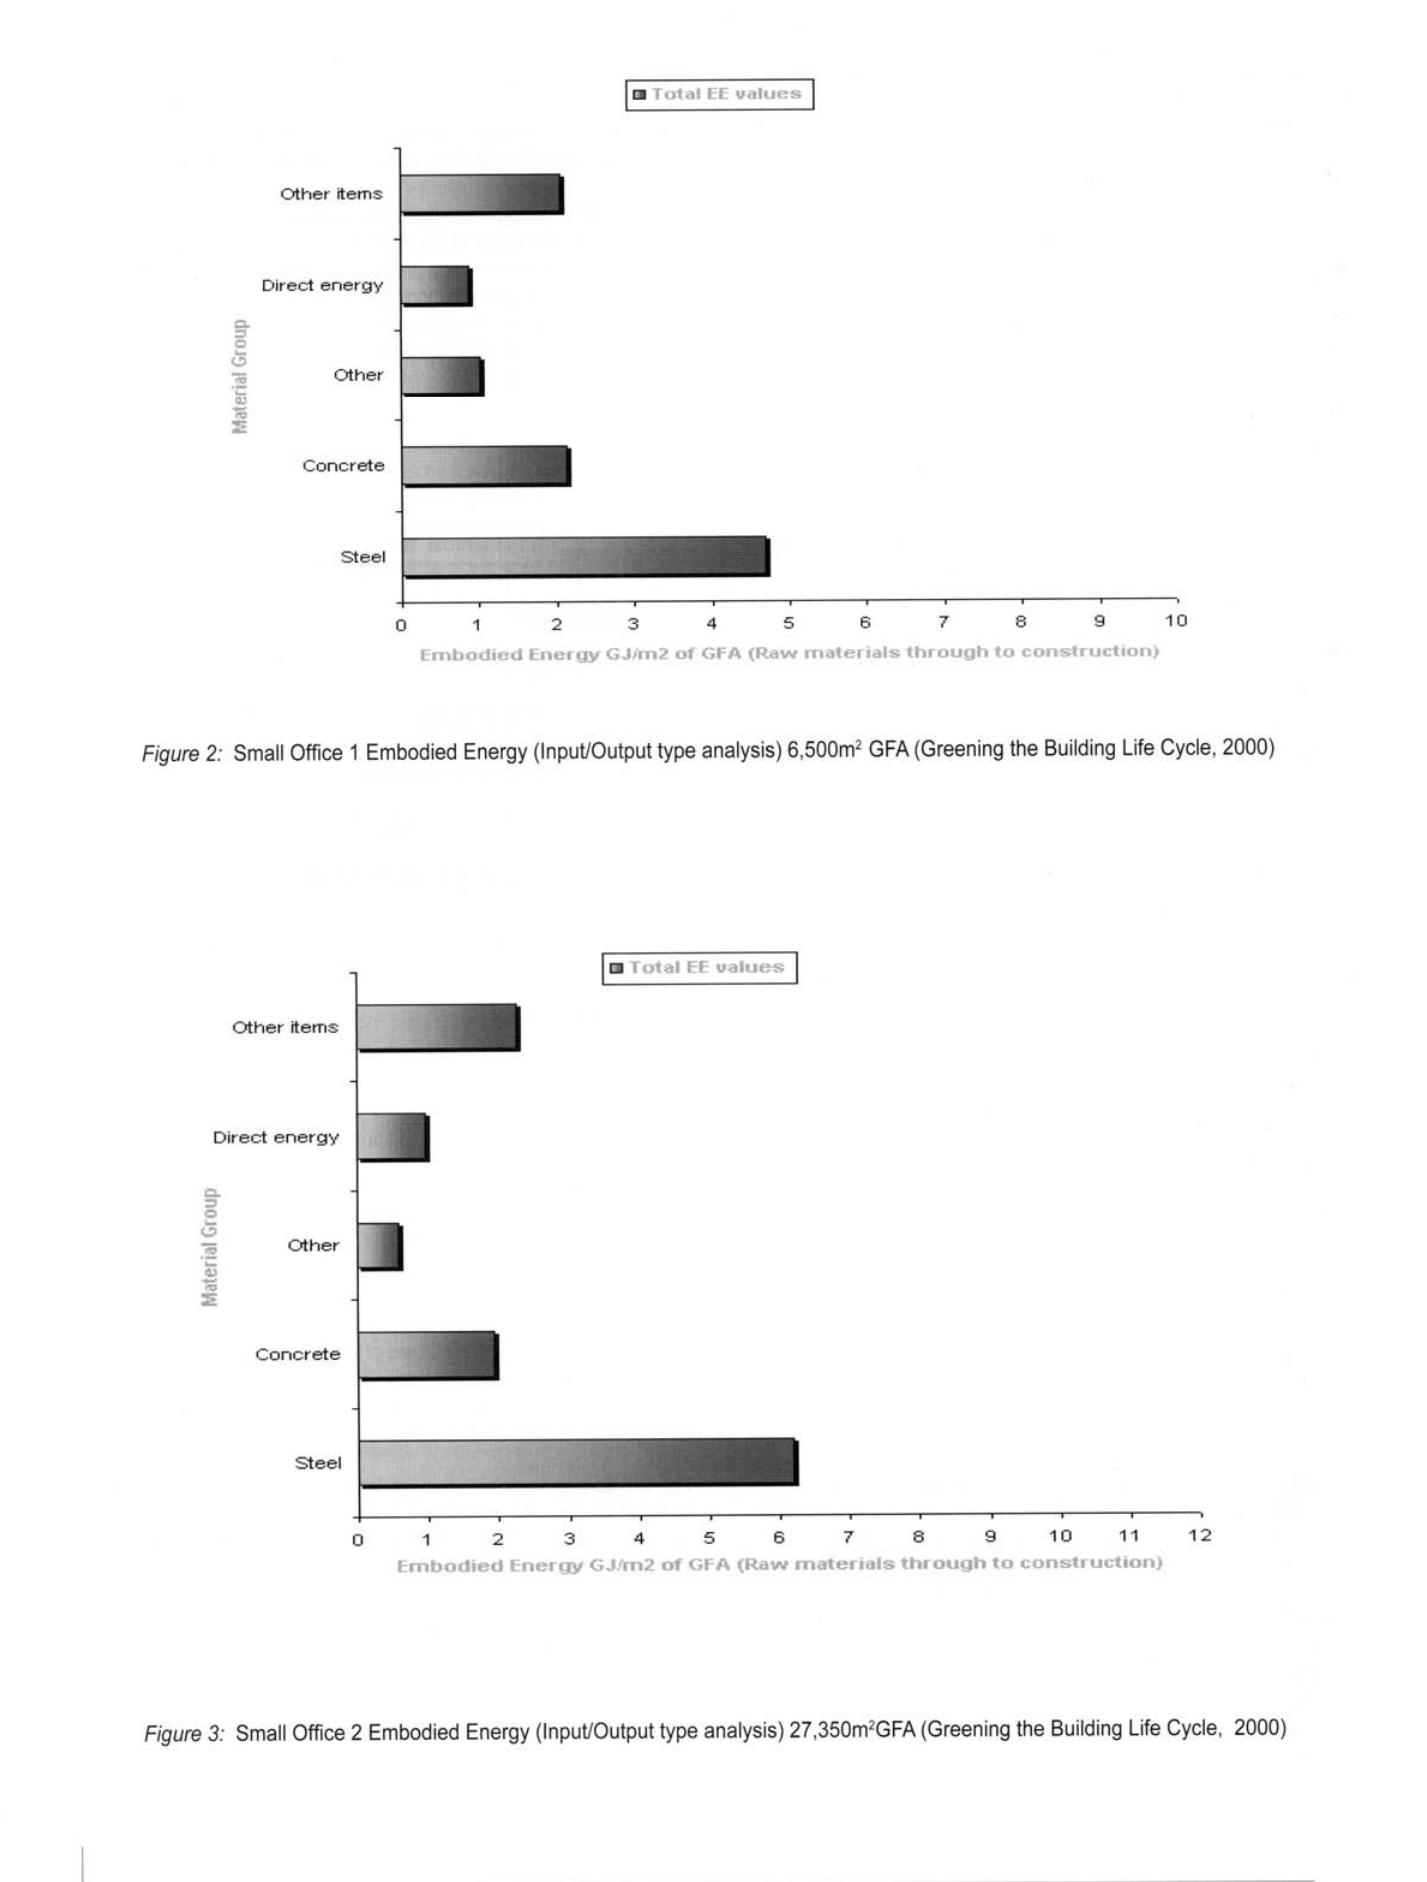
Figure 3: Small Office 2 Embodied Energy (Input/Output type analysis) 27,350m 2 GFA (Greening the Building Life Cycle,